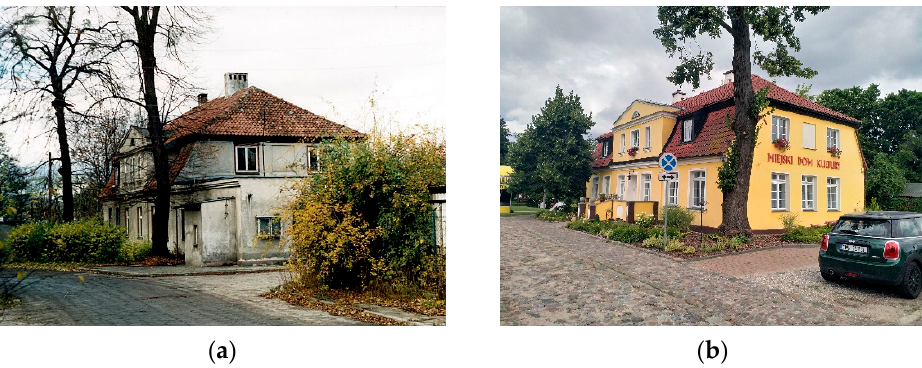
Figure 4. The manor house “Dw ó r pod lipami” from the second half of the 18th century; ( a ) before the renovation, source: [16]; ( b ) and after (picture from the summer of 2021), source: